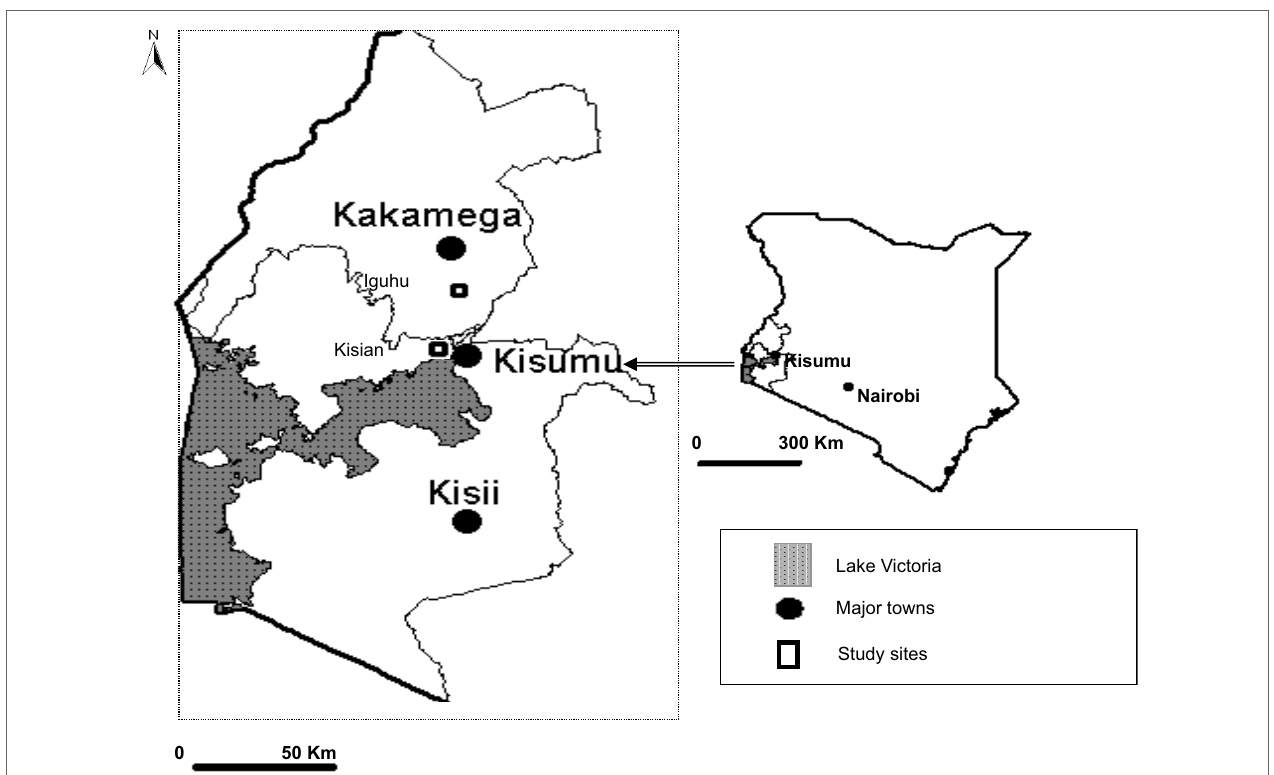
FigUre 1 | a map showing the selected sites in western Kenya highlands .